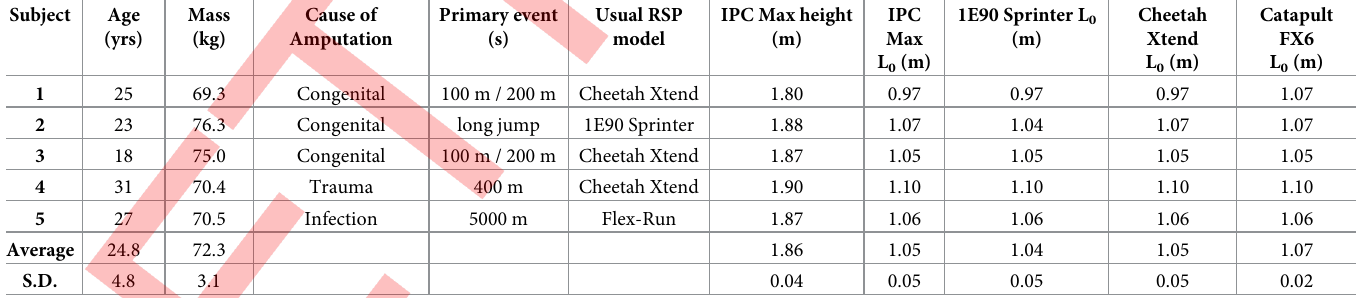
Table 1. Demographic and anthropometric data of subjects with bilateral transtibial